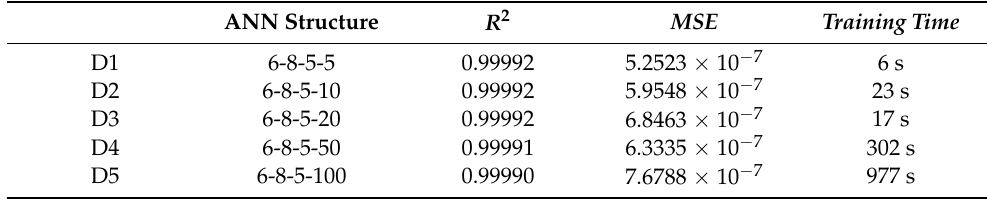
Table 2. MSE , R 2 , Training Time , and the ANN structure in each